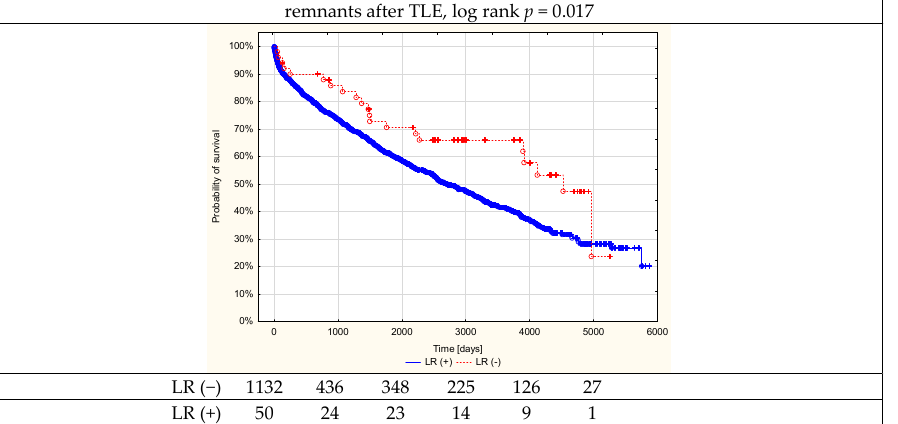
All patients gave their informed wri(cid:308)en consent to undergo TLE and use anonymous data from their medical records, approved by the Bioethics Commi(cid:308)ee at the Regional Chamber of Physicians in Lublin no. 288/2018/KB/VII. The study was carried out in ac- cordance with the ethical standards of the 1964 Declaration of Helsinki.